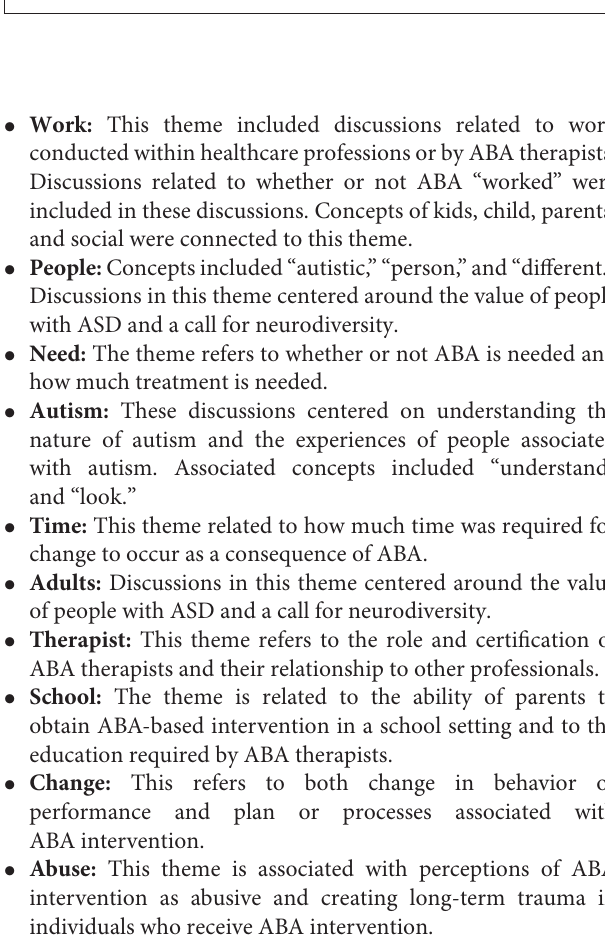
FIGURE 1 | Concept map of open-ended text response using Leximancer